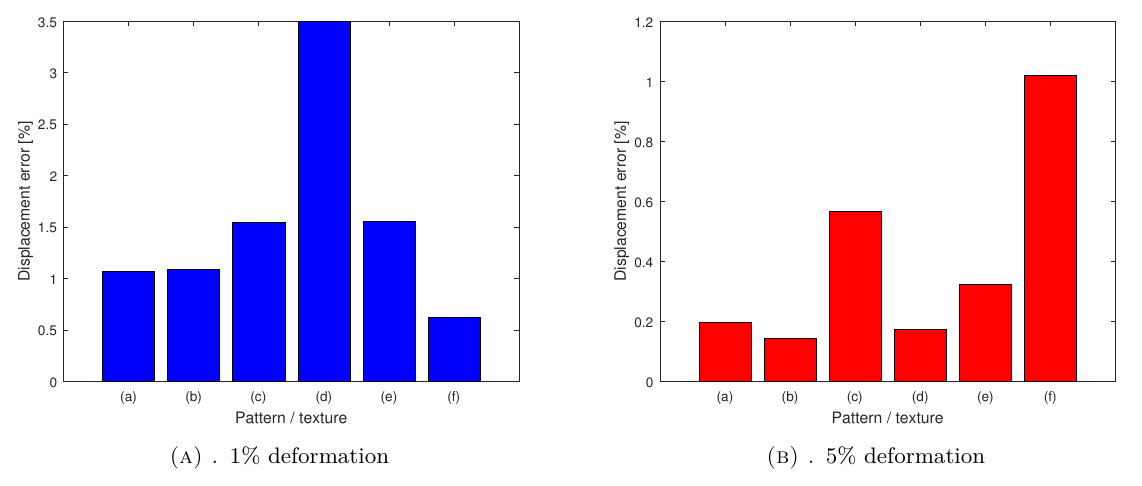
Figure 7. Displacement error for 10 × 10 px subset size.